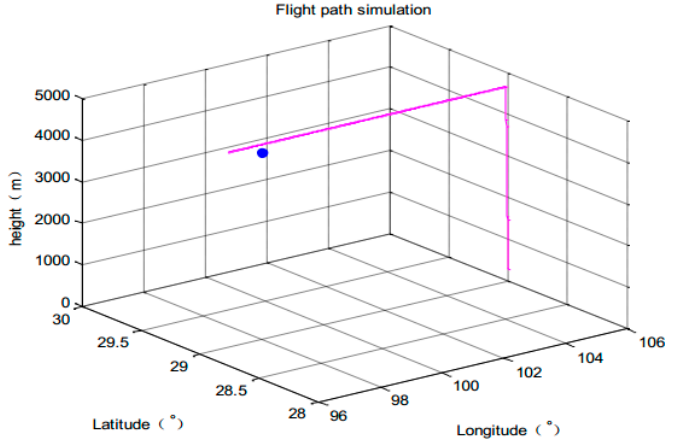
Figure 7. Aircraft trajectory.